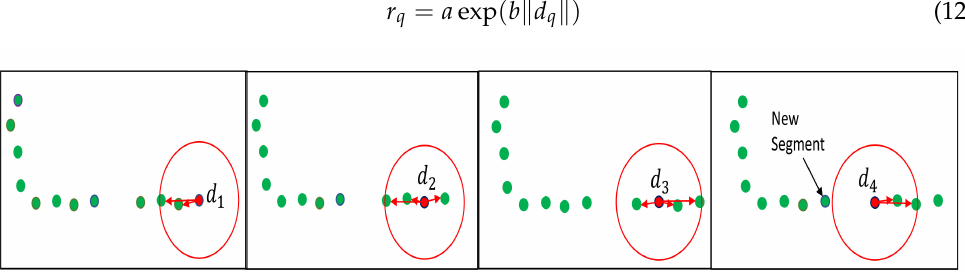
Figure 4. The Euclidean cluster extraction methodology [33] adopted in [3] with varying r q . Parameters a = 0.2 and b = 0.07 were selected for scan ranges between 0.5 and 30 m. Radius r q is taken as the varying euclidean distance. The SVED approach may produce both auxiliary and bleak segments [3], as shown in Figure 5.